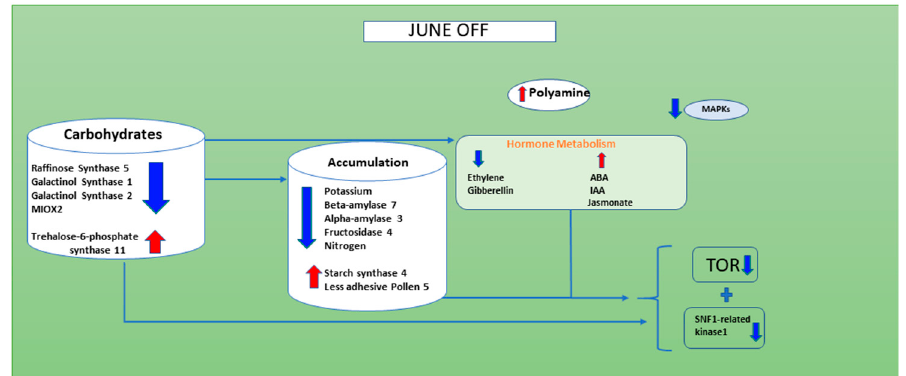
Figure 6. A figure showing the down-regulated genes in the inflorescence buds of non-fruiting branches of June “OFF” season. Red shows the up-regulated genes and blue shows the down-regulated genes. In this situation the inflorescence buds do not occur.